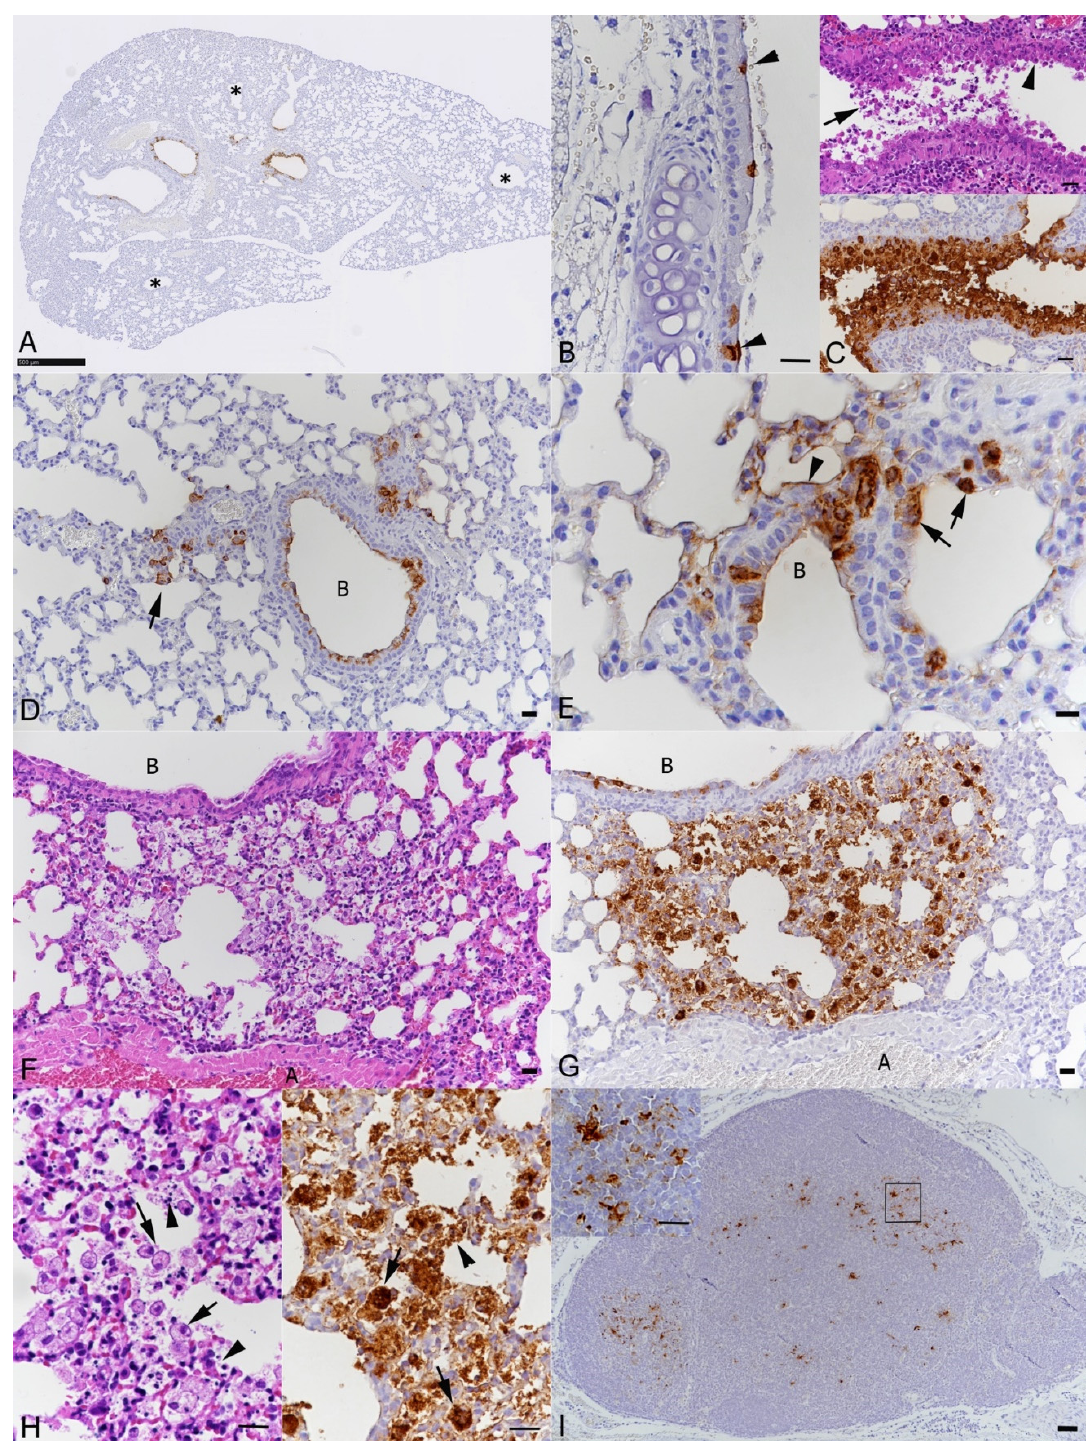
Figure 4. Histopathological changes and SARS-CoV-2 NP expression in airways and lungs of BALB-C mice after intranasal infection with 2 × 10 5 PFU of beta variant. ( A – E ). Female animal euthanized at 2 dpi. ( A ). Left lung lobe, longitudinal section, overview. Viral antigen expression in individual to almost all epithelial cells in several bronchioles. Other bronchioles are entirely negative (*). Bar = 500 µm. ( B ). Trachea with a few individual ciliated epithelial cells expressing viral antigen (arrowheads). Bar = 10 µm. ( C ). Lung; larger bronchiole with degeneration of epithelial cells (arrowhead) and degenerate cells in the lumen (arrow) and extensive viral antigen expression. There is also a mild peribronchiolar lymphocyte infiltration. Bar = 20 µ m. ( D ). Lung with viral antigen expression in bronchiolar epithelial cells and pneumocytes in adjacent